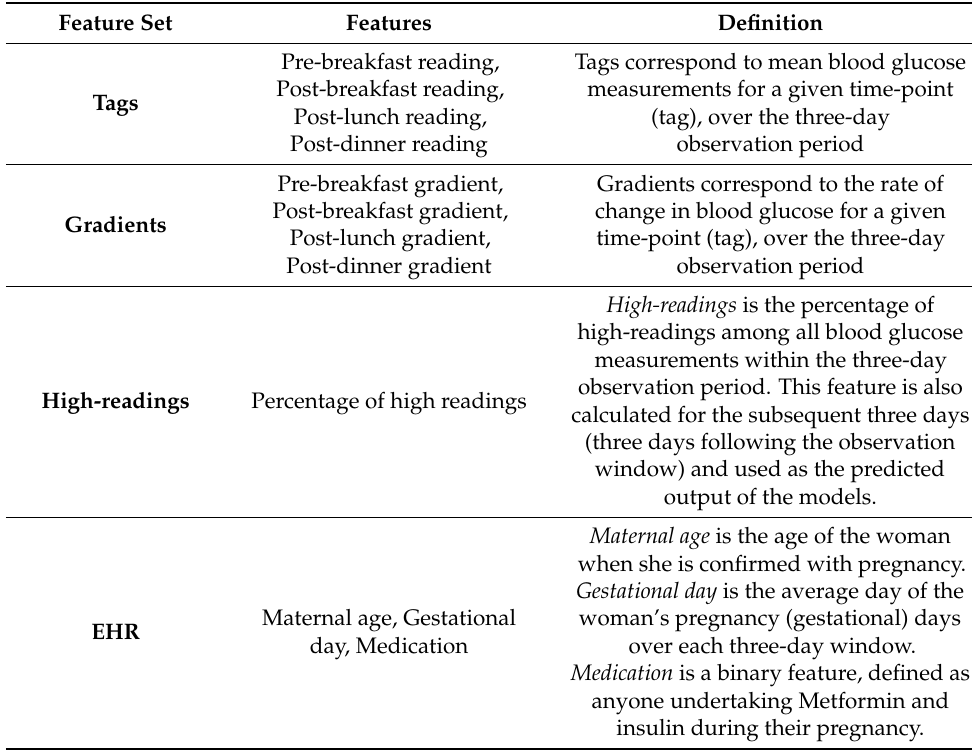
Table 1. Feature sets used in model